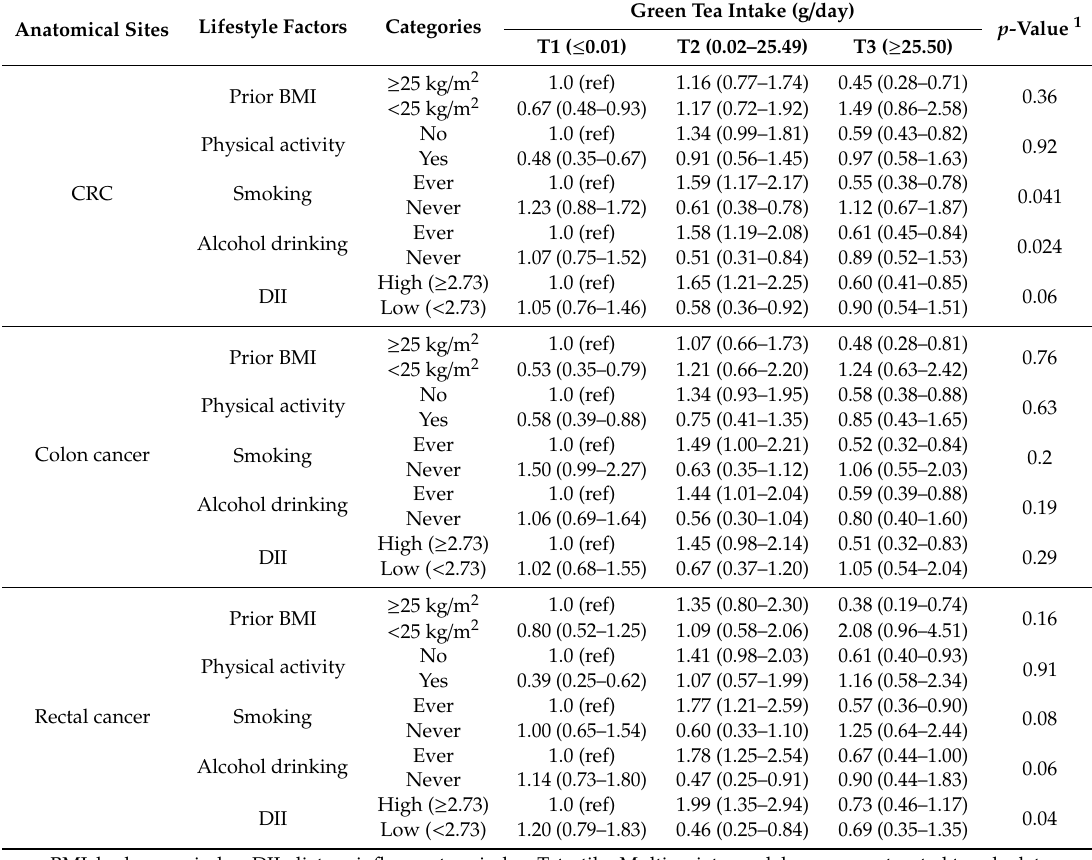
Table 4. Protective e ff ect of green tea consumption and health-related factors on CRC.